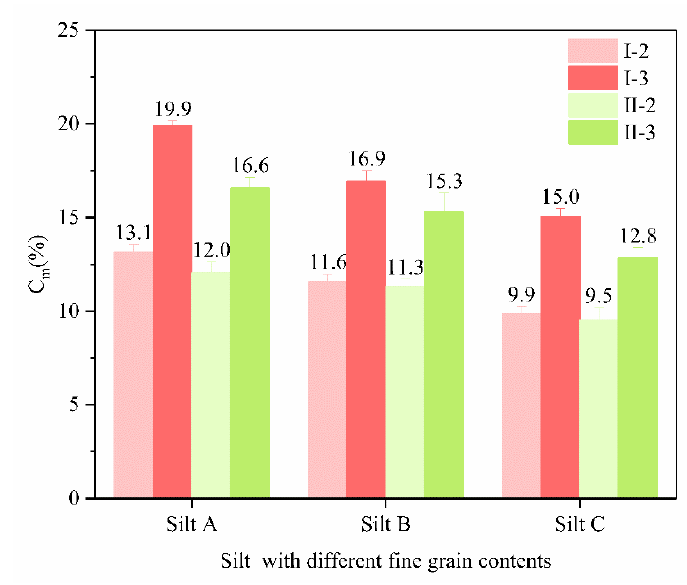
Figure 5. Effect of different fine particle content on calcium carbonate production.